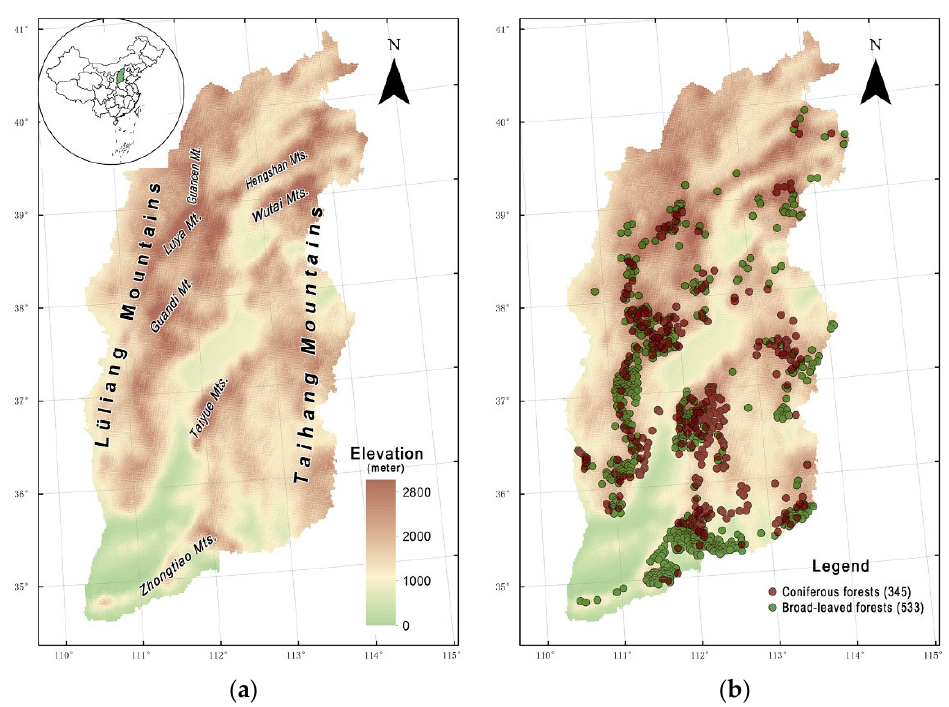
Figure 1. Maps showing the general topography in Shanxi Province ( a ) and the distribution of the sample plots for the investigation of biomass carbon density of natural broad-leaved and coniferous forests in the region ( b ). The number in parentheses denotes the number of the sample plots.